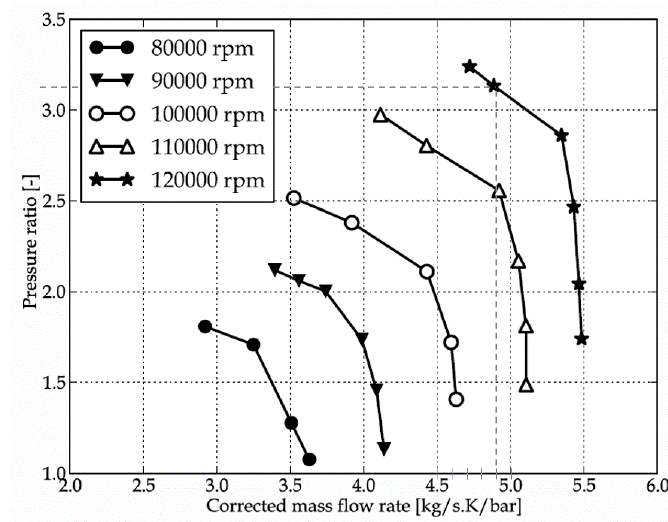
Figure 4. BMT compressor map (Pressure ratio vs Corrected mass flow).